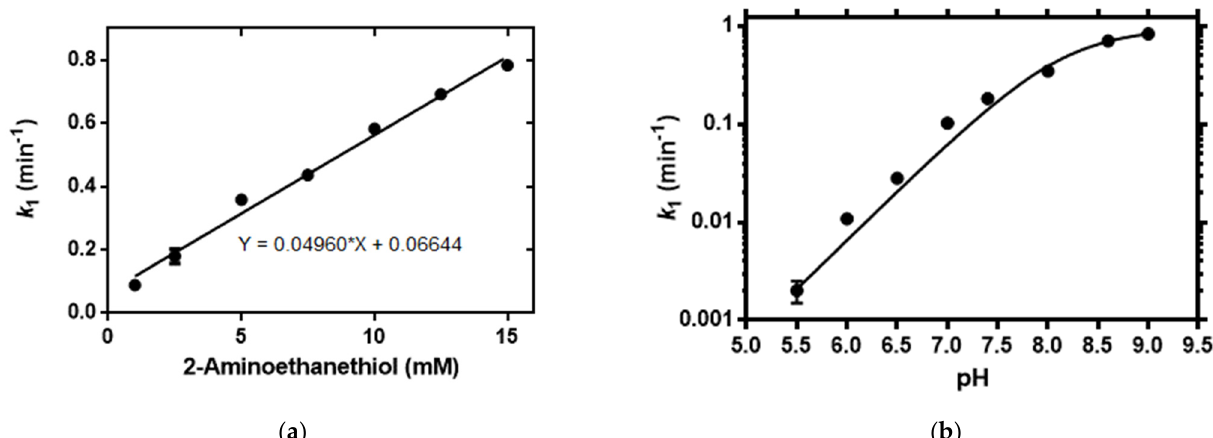
Figure 3. Titration studies to decrypt the reaction mechanism of 16b with 2-AET. ( a ) Kinetic analysis of 2-AET titration on the 2-AET– 16b reaction was performed in the presence of 0.4 μ M of 16b . ( b ) Kinetic analysis of pH titration on the 2-AET– 16b reaction was carried out in the presence of 0.4 μ M of 16b and 5 mM of 2-AET, while varying the pH. Please see Section 3.3 for the experimental details. Each reaction was analyzed at least three times in order to acquire the averaged k 1 values and standard deviation (the error bar).